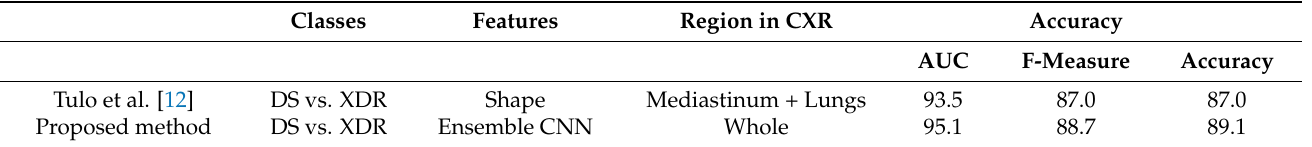
Table 10. The accuracy of the proposed methods with the existing heuristics to classify DS-TB and XDR.